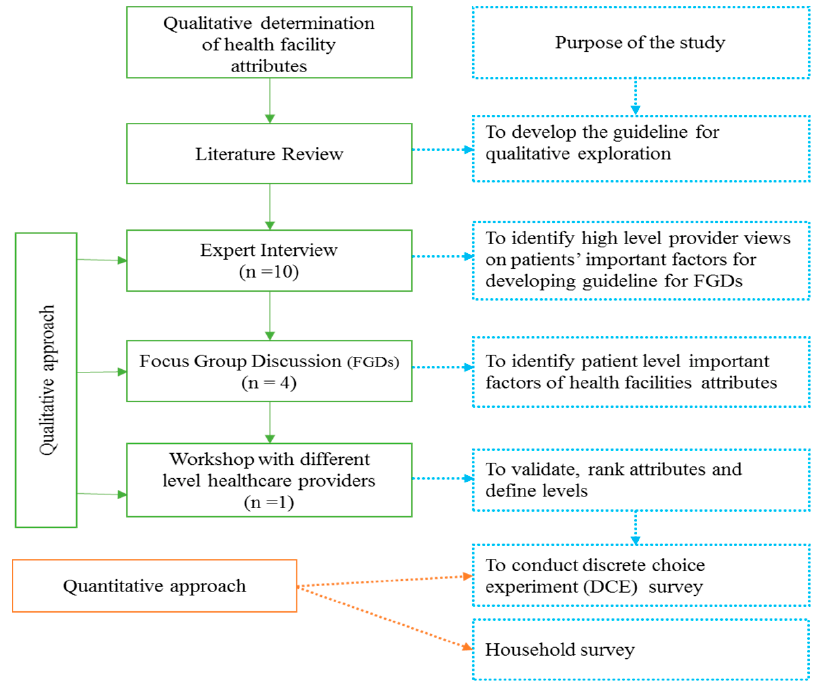
Figure 1. The study flowchart.